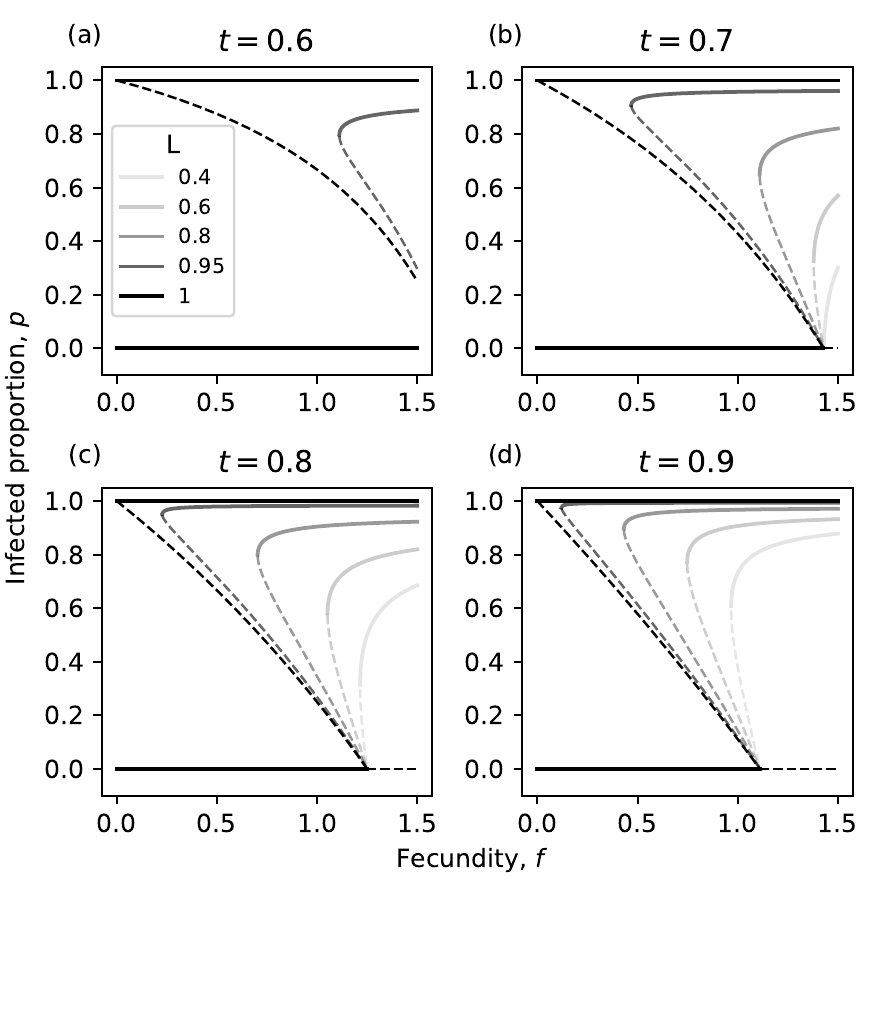
Figure 3. Equilibria of the diplodiploid model (Eq. (1)) as function of f , for different values of t (panel titles) and L (colours of the lines, see legend). Solid lines: stable equilibria. Dashed lines: unstable